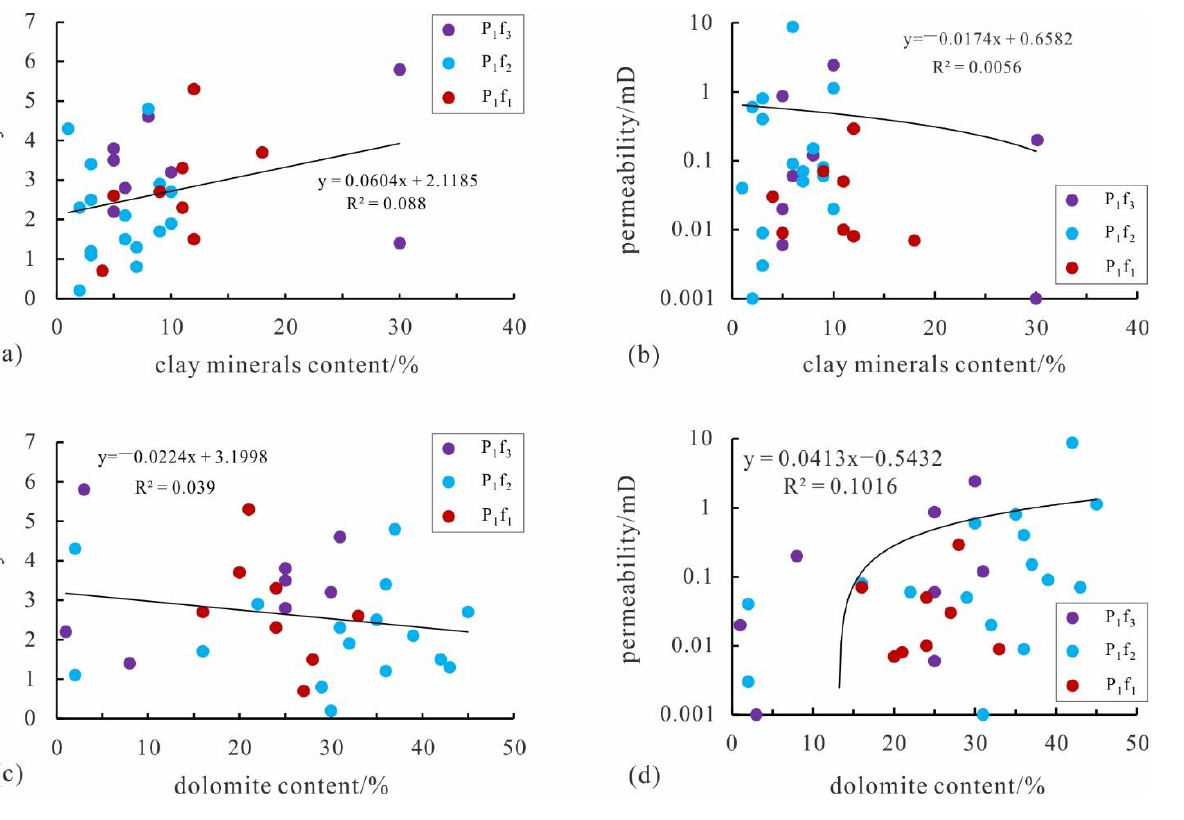
Figure 9. Relationship between mineral content and physical properties: ( a ) clay minerals content versus Porosity; ( b ) clay minerals content versus permeability; ( c ) dolomite content versus Porosity; ( d ) dolomite content versus permeability.